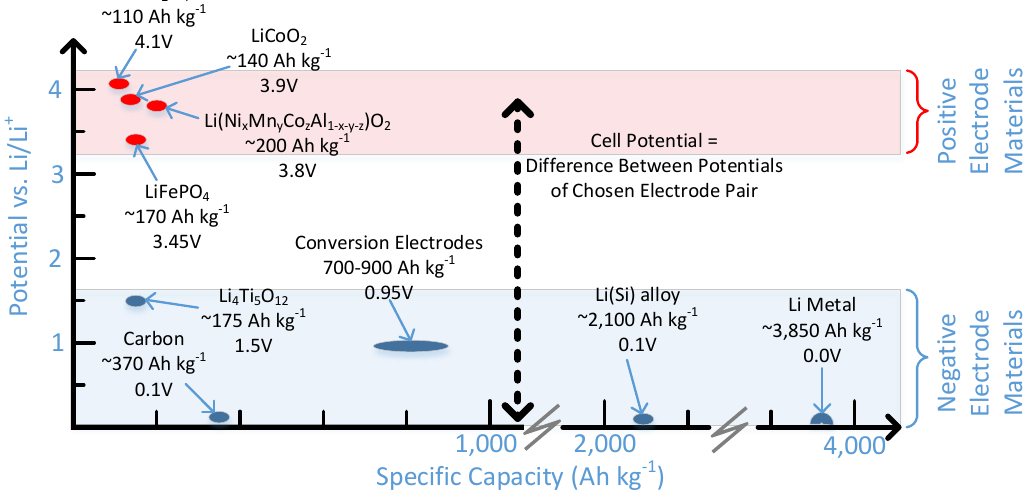
Figure 3. A summary of some present and future electrode chemistry options for Li-ion batteries. The proposed capacity of the Li(Si) is 50% of the theoretical capacity of the material, similar to the case found for some of the positive electrode materials.